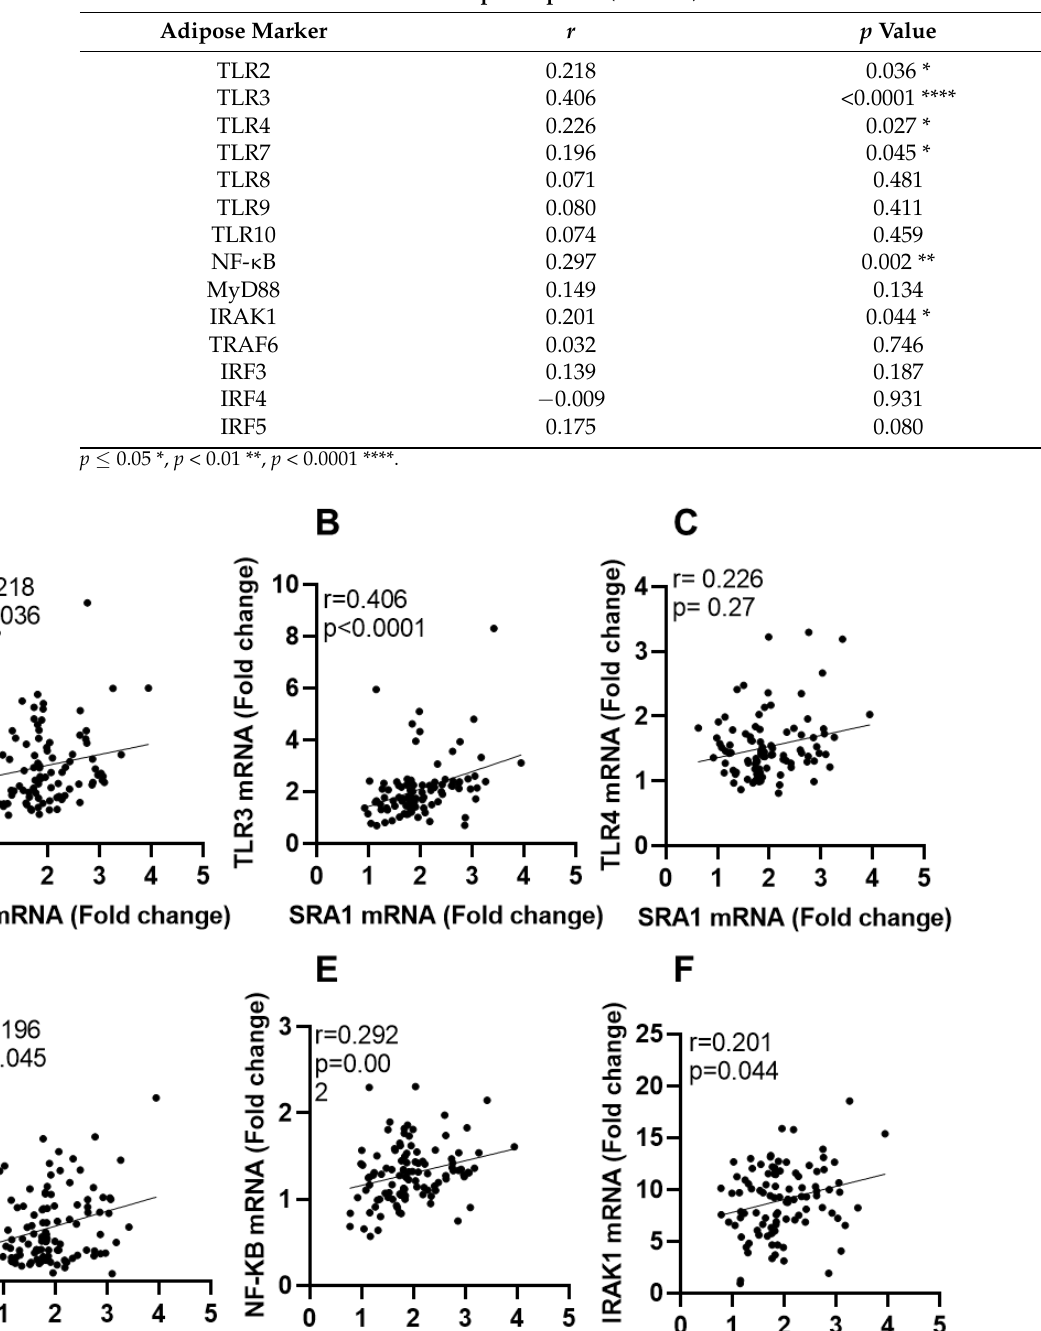
Table 2. Spearman ’ s correlation analysis of adipose gene expression of SRA1 with TLRs, their sig- naling mediators, and IRFs in the total study population.